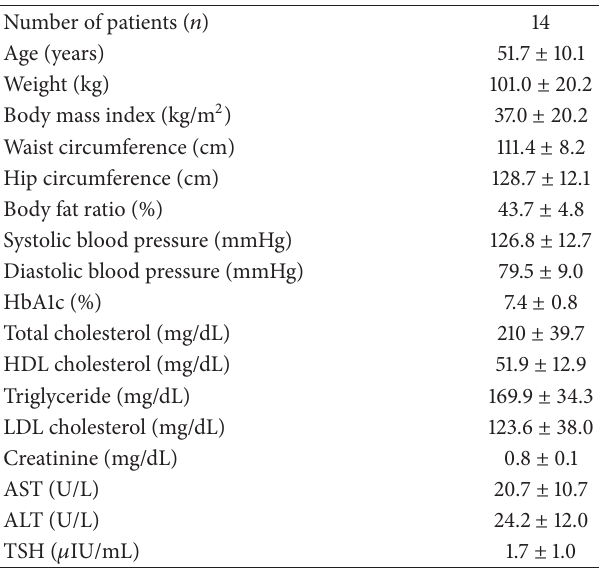
Table 1: Demographic characteristics and laboratory parameters of study patients.